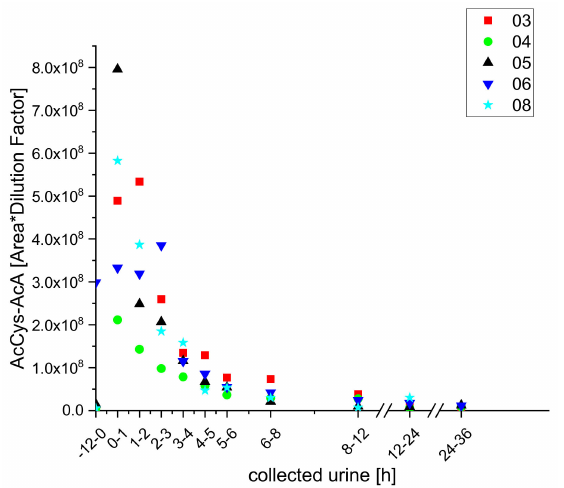
Figure 13. Excretion kinetics of AcCy-AcA: UPLC-qToF-MS / MS measurements of contents in samples of urine from participants three, four, five, six, and eight at indicated times after co ff ee consumption